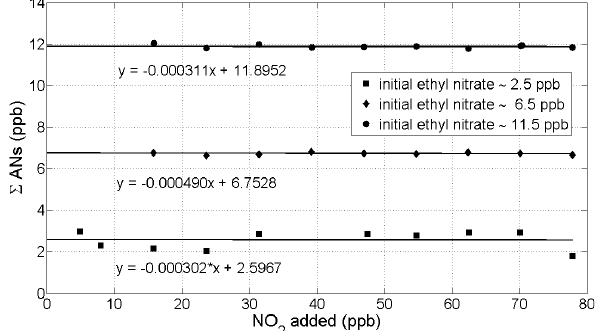
Figure 7. Measurements of ∑ANs when the TD-LIF sampled a mixture of ethyl nitrate and 2 Fig. 7. Measurements of P ANs when the TD-LIF sampled a mix- ture of ethyl nitrate and different concentrations of NO 2 to check for different concentrations of NO 2 to check for possible interference of the recombination of 3 possible interference of the recombination of compounds produced compounds produced during the dissociation of ∑ANs. This experiment was carried out for 4 during the dissociation of P ANs. This experiment was carried out different initial concentrations of ethyl nitrate. 5 for different initial concentrations of ethyl nitrate.